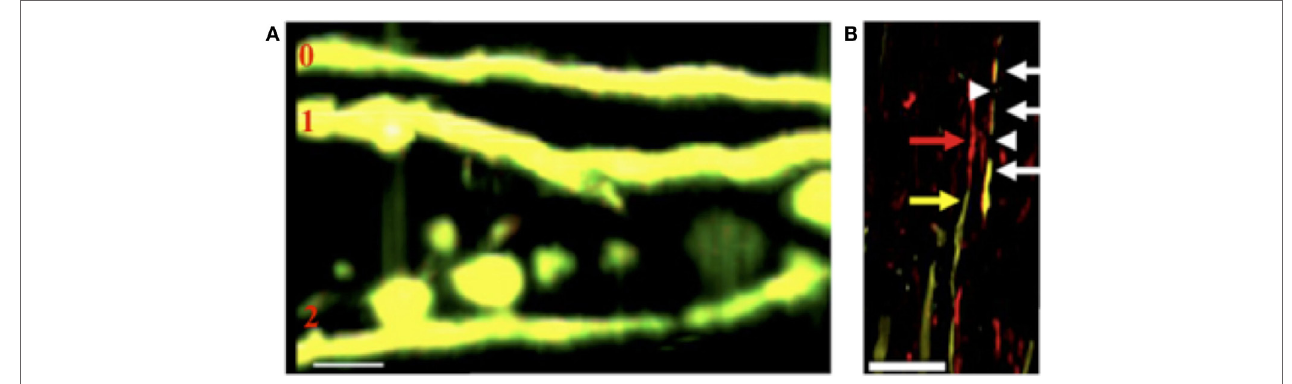
FiGURe 2 | (A) Representative 2P image of axons in JHMV-infected Thy1-YFP mice shows FAD stages 0, 1, and 2, 21 days post-infection (53). (B) Representative image of SMI32 immunohistochemistry (non-phosphorylated neurofilament) in Thy1-YFP mice, 23 days post-infection shows YFP + SMI32 − sections (yellow arrow), YFP + SMI32 + sections (white arrow), YFP − SMI32 + sections (red arrow), and YFP − SMI32 − sections (white arrowhead) (53). (Scale bar = 20 μ